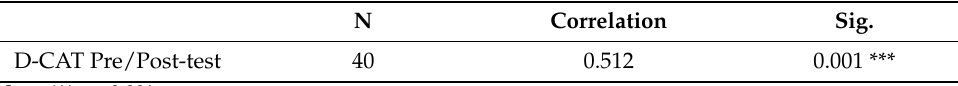
Table 4. Paired sample correlations of D-CAT. N Correlation